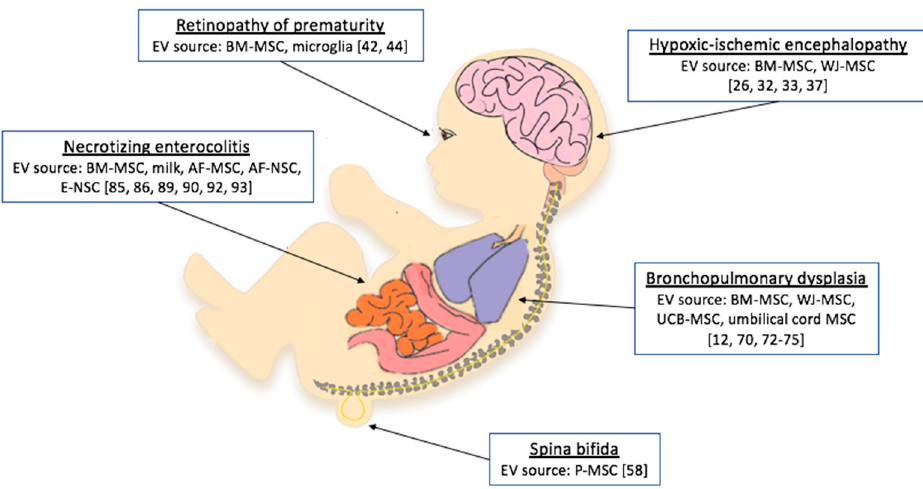
Figure 1. Neonatal conditions for which studies have tested extracellular vesicle (EV) administration as a treatment option. BM-MSCs, bone marrow mesenchymal stem cells; AF-MSCs, amniotic fluid mesenchymal stem cells; AF-NSCs, amniotic fluid neural stem cells; E-NSCs, neonatal enteric neuronal stem cells; P-MSCs, placental mesenchymal stem cells; WJ-MSCs, umbilical cord Wharton’s jelly mesenchymal stem cells; UCB-MSCs, umbilical cord blood-derived mesenchymal stem cells [12,26,32,33,37,42,44,58,70,72–75,85,86,89,90,92,93].